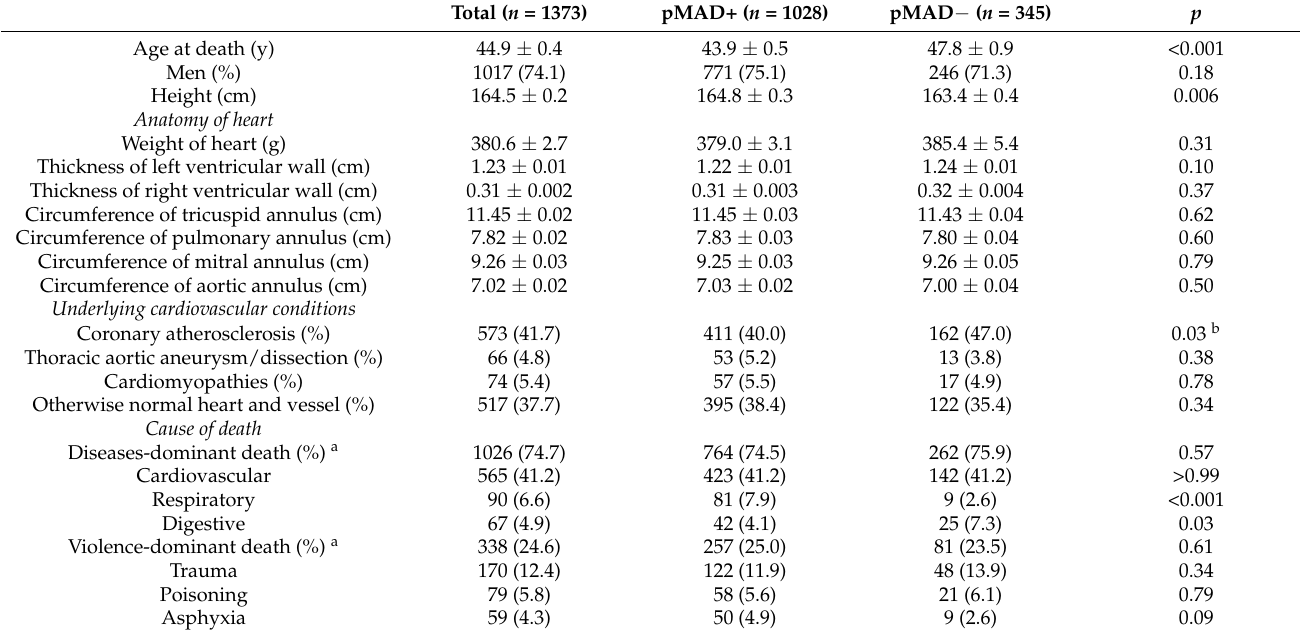
Table 2. Demography of study